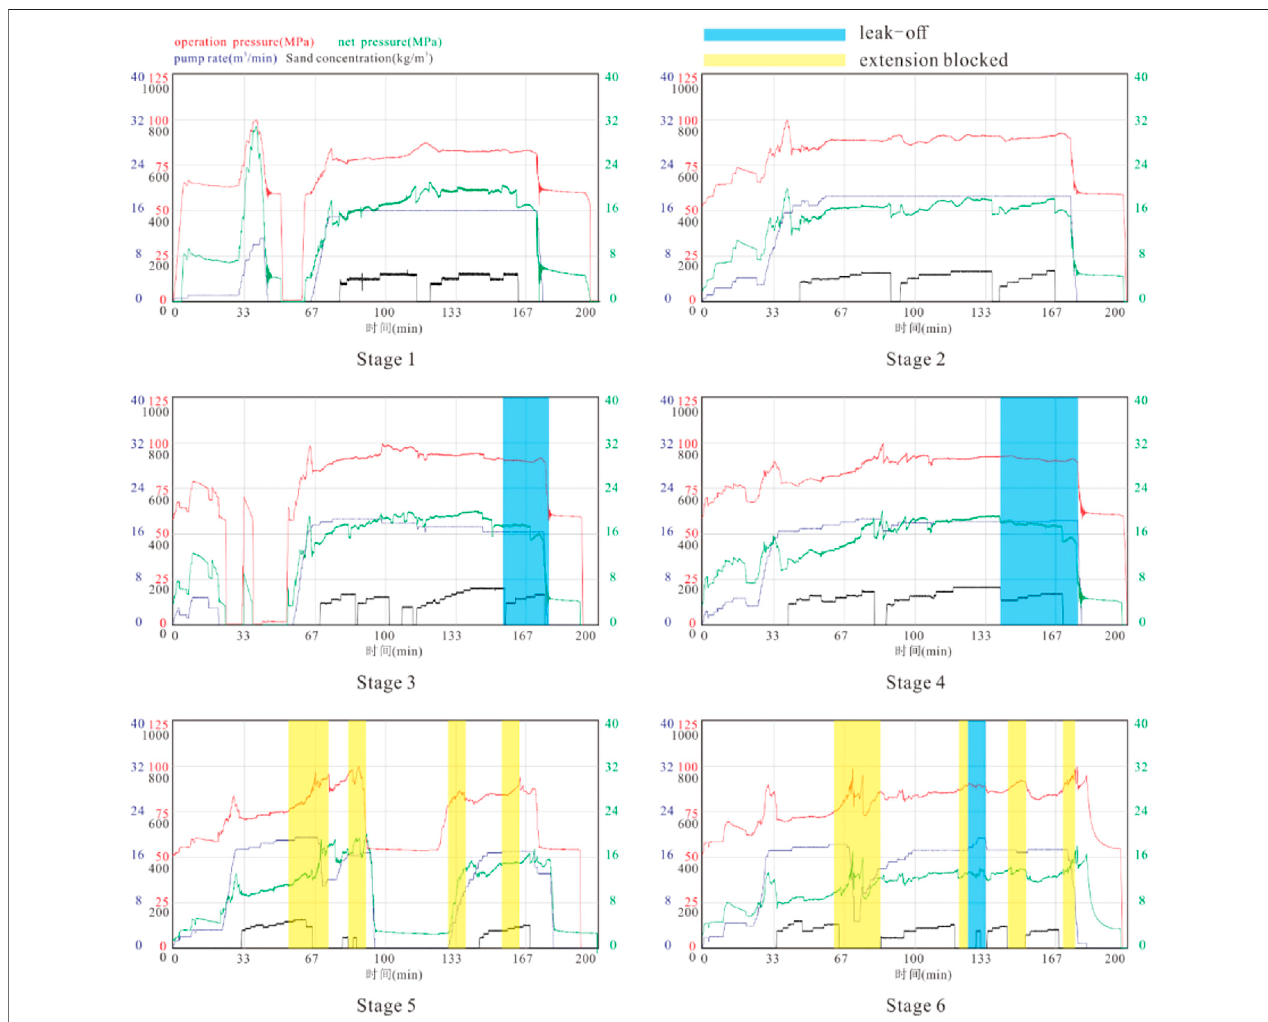
FIGURE 13 | Net pressure results of stage 1 through six frac operation curve diagnosis in H7 – 3 well.